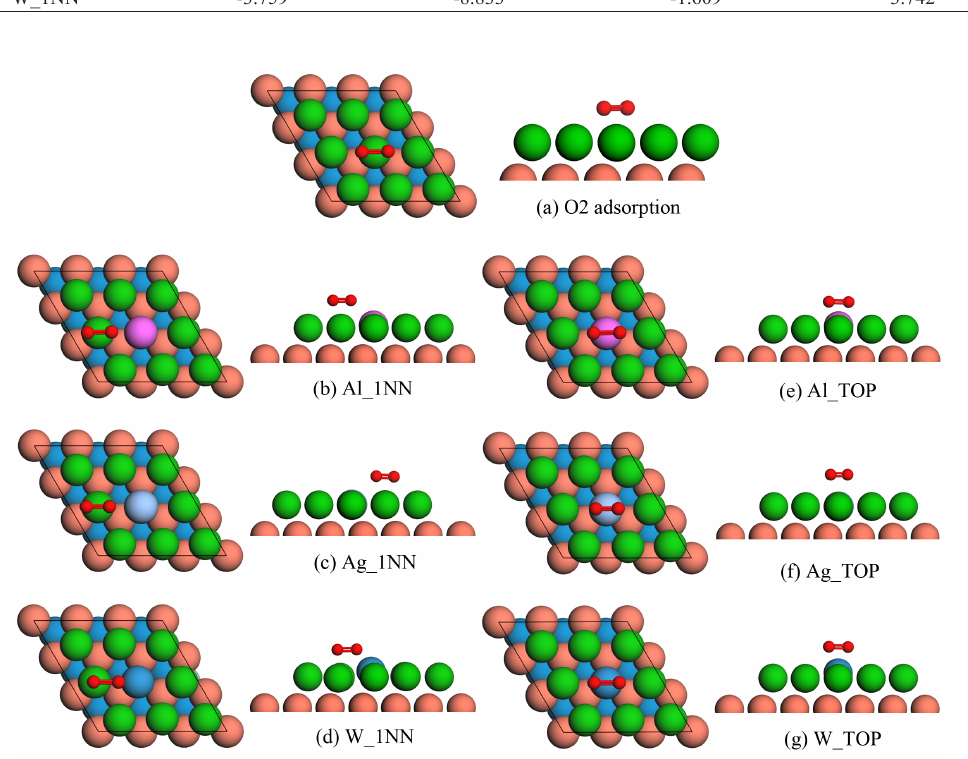
adsorption on the pristine/doped Cu surfaces. The white, maroon and brown particles 2